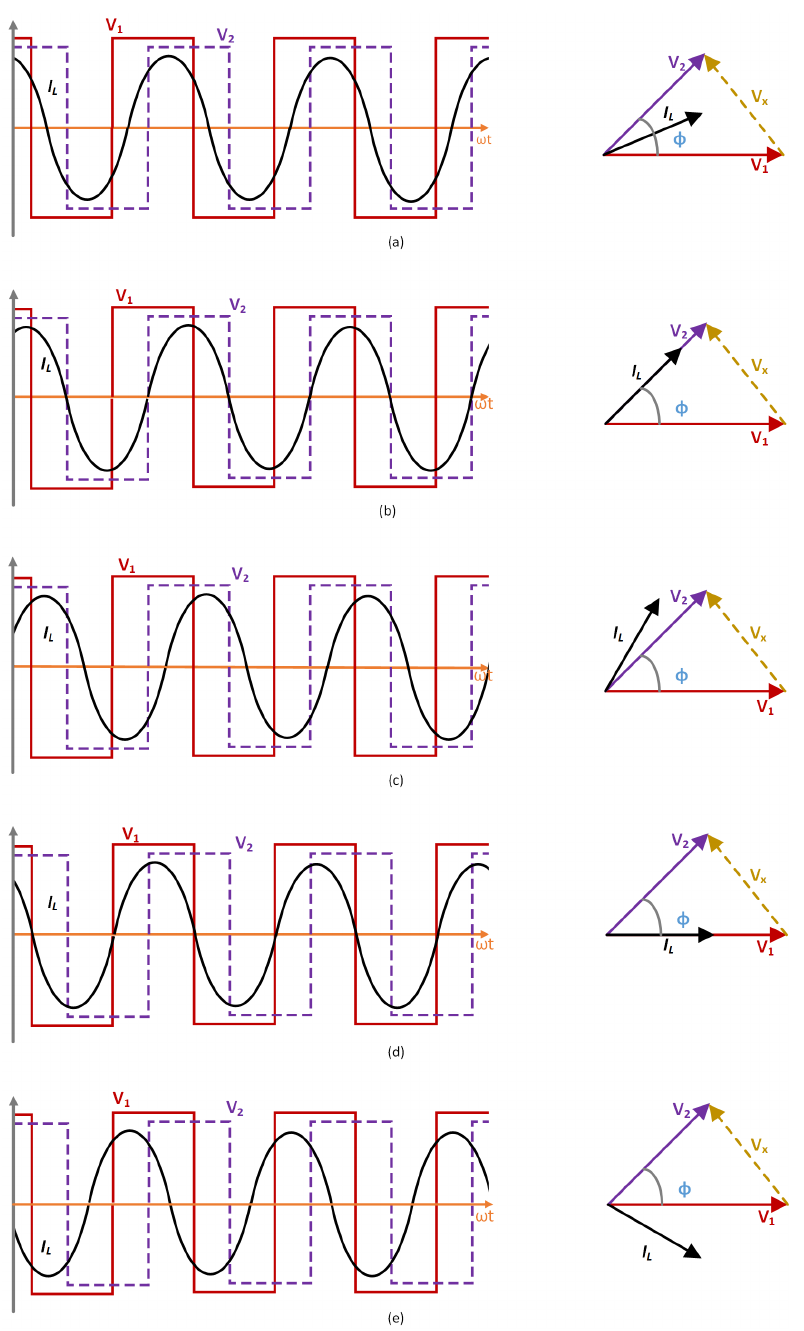
Figure 12. ( a ) For cos ( φ ) < M < 1 , ZVS was achieved for the primary and secondary side cos ( φ ) switches. ( b ) For M = cos ( φ ) , the primary and secondary side switches achieved ZVS and ZVS under the boundary conditions, respectively. ( c ) For M < cos ( φ ) , the primary side switches achieved ZVS and the secondary side switches lost ZVS. ( d ) For M = 1 , the primary and secondary cos ( φ ) side switches achieved ZVS under the boundary conditions and achieved ZVS, respectively. ( e ) For M > 1 , the primary side switches lost ZVS and the secondary side switches achieved ZVS. cos ( φ ) In the proposed topology, to achieve full-range soft switching, the frequency